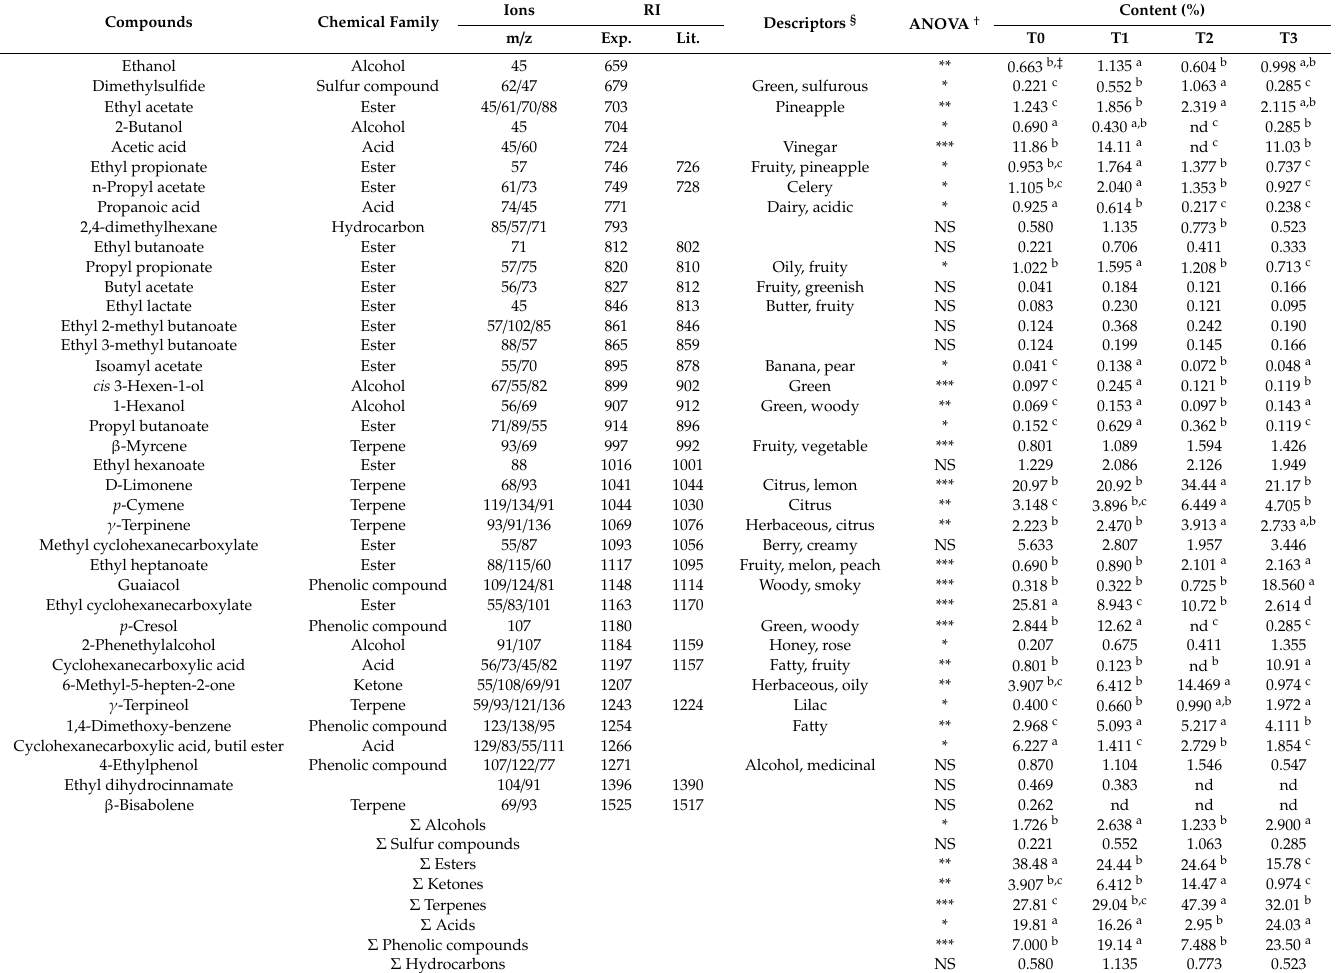
Table 2. Retention indexes, sensory descriptors and percentage of total area of volatile compounds found in table olives as a ff ected by the irrigation